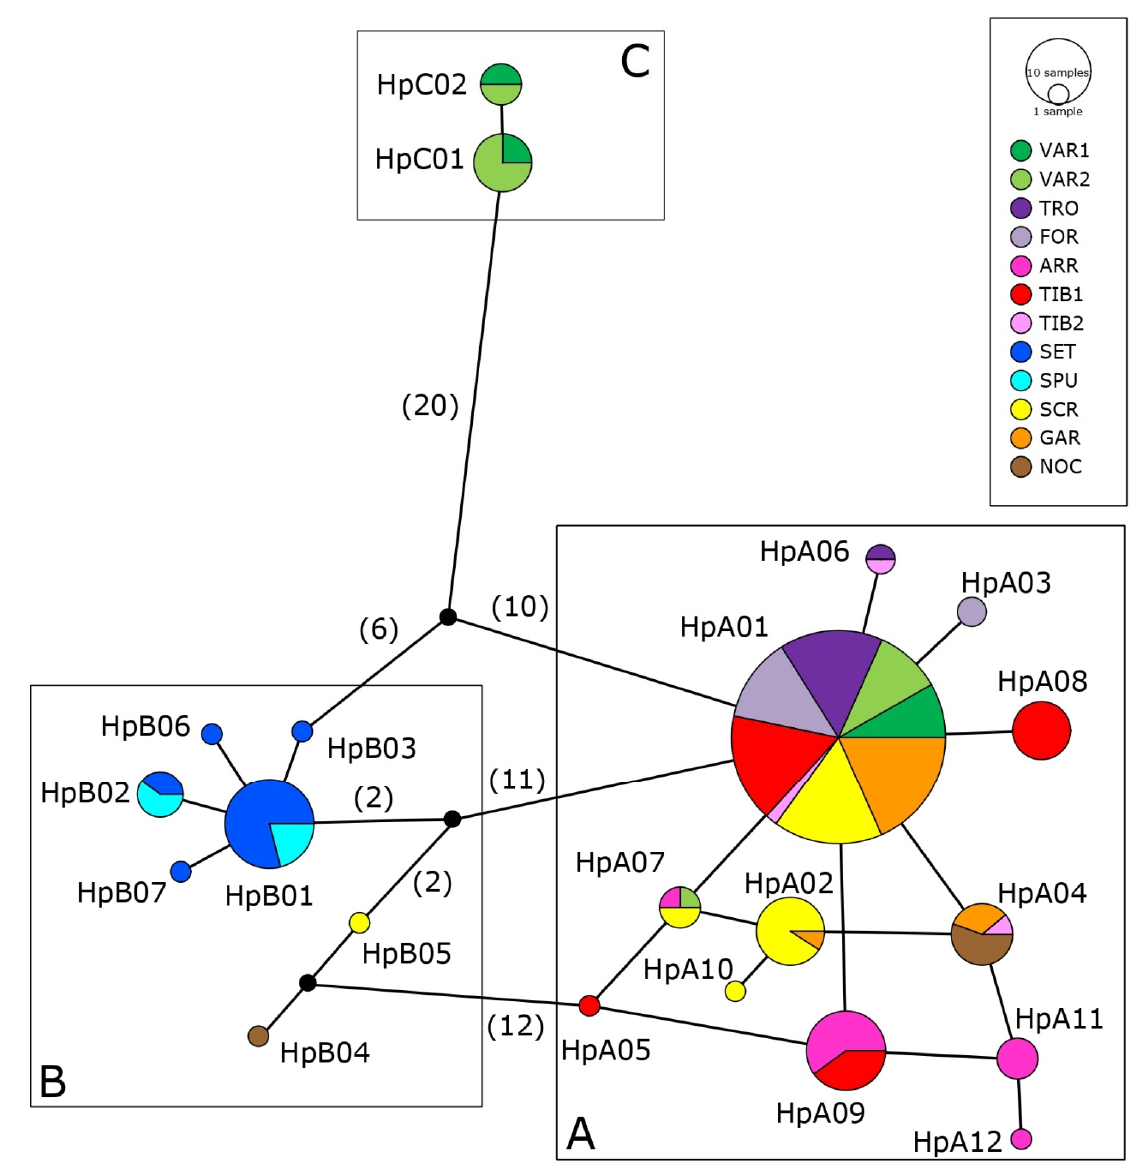
Figure 3. Haplotype network based on CR sequences. Each circle corresponds to one haplotype and its dimension is proportional to the haplotype frequency. The number of nucleotide substitutions between haplotypes is indicated in parenthesis. Boxes highlight the three haplogroups found in this study (A, B and C, see Results). Population abbreviations refer to Table 1.